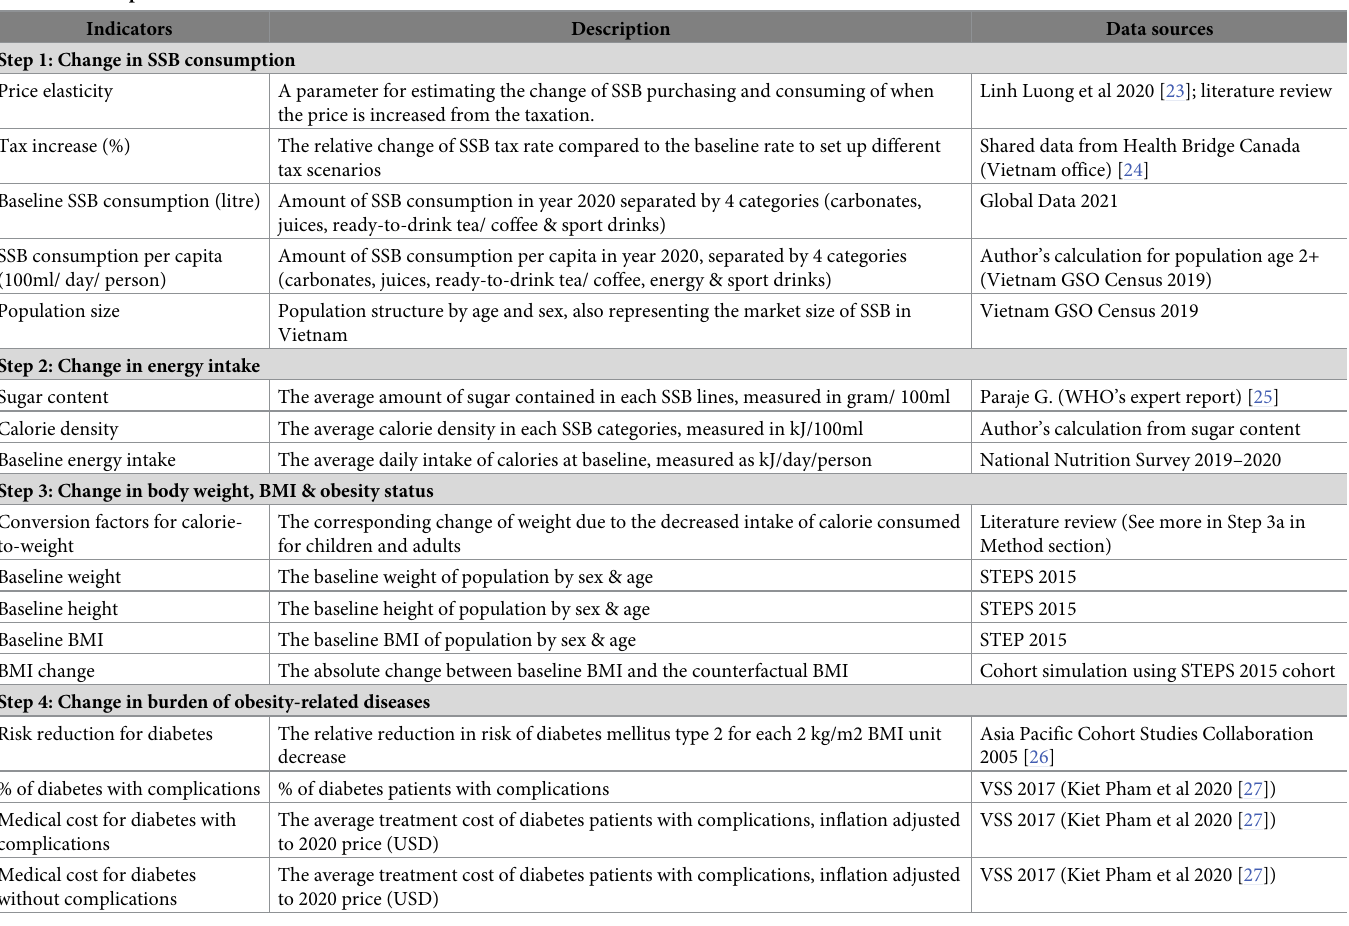
Table 1. Model parameters & data sources.